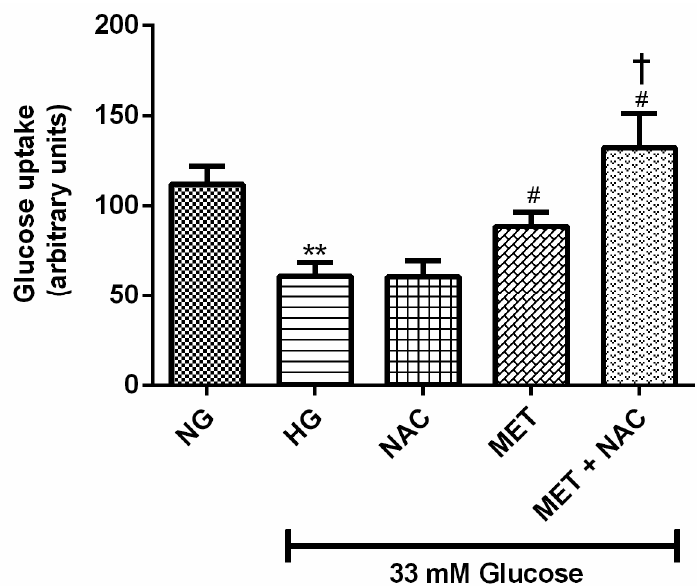
Figure 2. The combination e ff ect of Metformin (MET) and N-acetylcysteine (NAC) on high glucose-induced H9c2 cells glucose uptake. H9c2 cardiomyoblasts were cultured in high glucose (HG; 33 mM) for 24 h. Cardiomyoblasts were then co-treated with NAC (1 mM), metformin (MET) (1 µ M) and a combination of MET + NAC. Cells treated with normal glucose (NG) served as the vehicle control. Data are presented as the mean ± SEM of 3 distinct biological experiments with each experiment having 3 technical repeats ( n = 9). Significance is depicted as ** p ≤ 0.01 versus NG control, # p < 0.05 versus HG control † p < 0.05 versus NAC only.